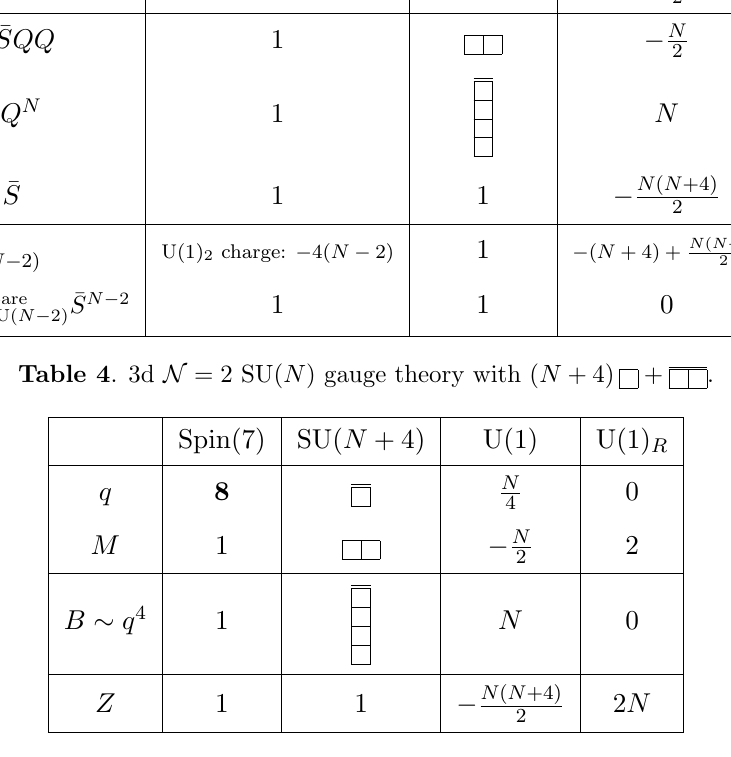
Table 5 . The Spin(7) magnetic dual description of table